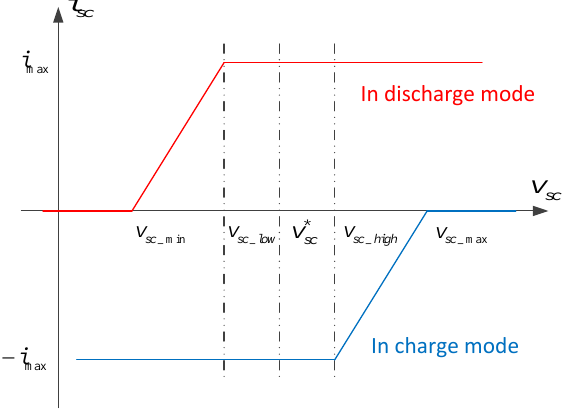
Figure 4. Constraints of